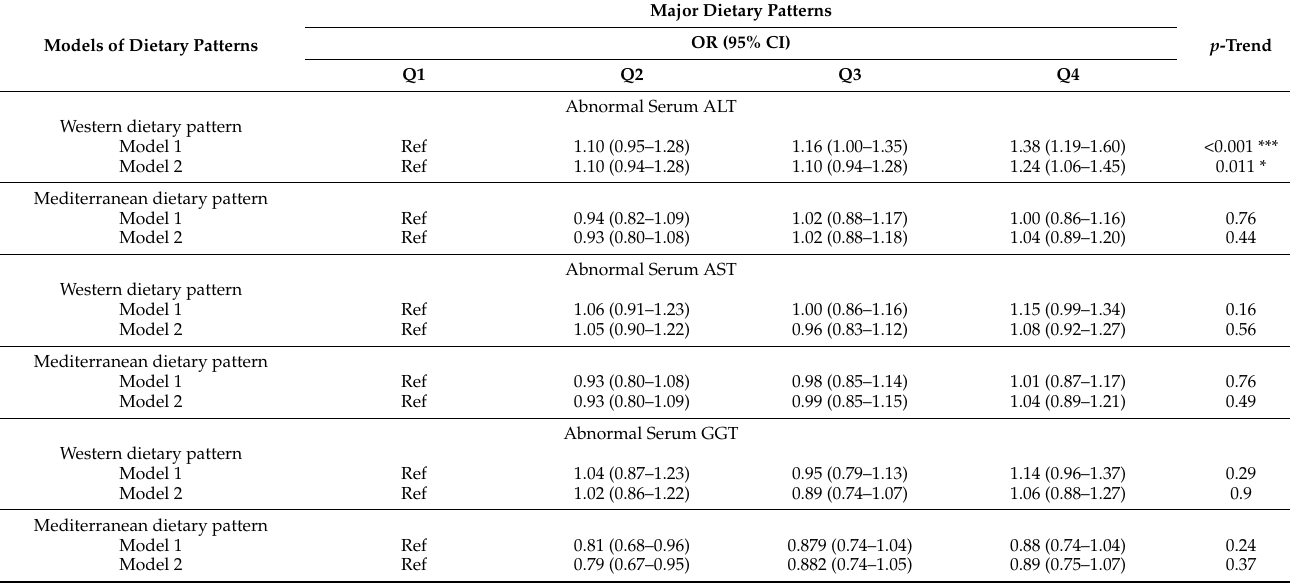
Table 5. Odds ratios for abnormal serum hepatic enzyme levels across quartiles of major dietary patterns ( n = 15,005) 1 .